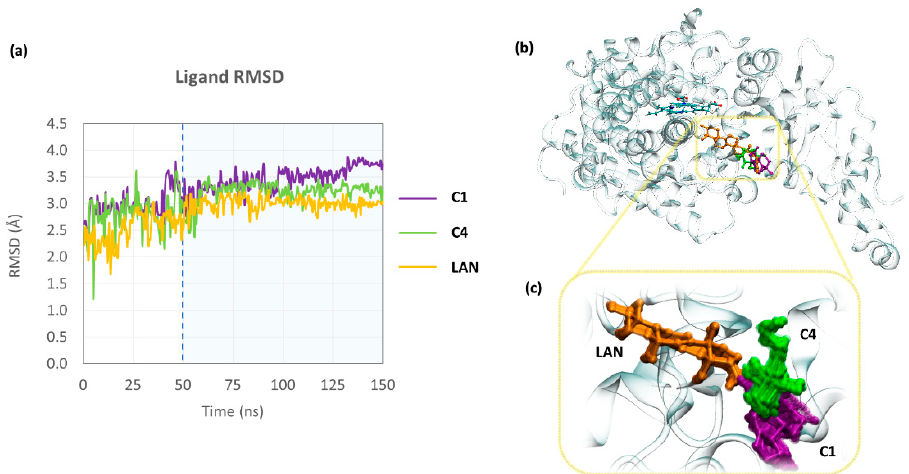
Figure 2. ( a ) Ligand RMSD (Å) calculations for 14-alpha demethylase complexes with C1 (purple), C4 (green) and LAN (orange) obtained from protein-aligned trajectories during the last 50 ns out of 150 ns MD simulations. ( b ) Representative equilibrated structures for 14-alpha demethylase complexes with C1 (purple), C4 (green) and LAN (orange) obtained from the analysis of 50 ns out of 150 ns MD trajectories. ( c ) Time evolution of the binding poses of C1 (purple), C4 (green) and LAN (orange) in complex with 14-alpha demethylase during the last 50 ns out of 150 ns MD trajectories.